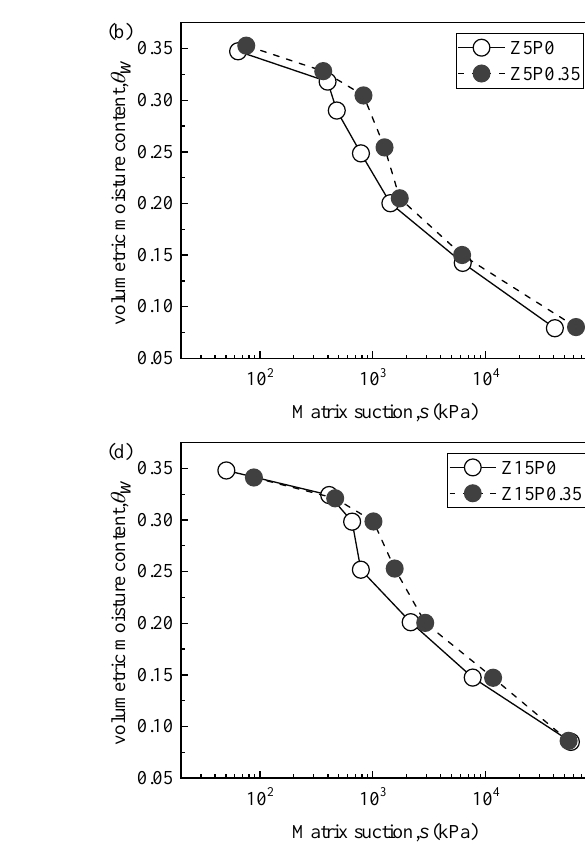
Figure 10. The soil – water characteristic curve of modified CCC with different replacement contents of clinoptilolite.